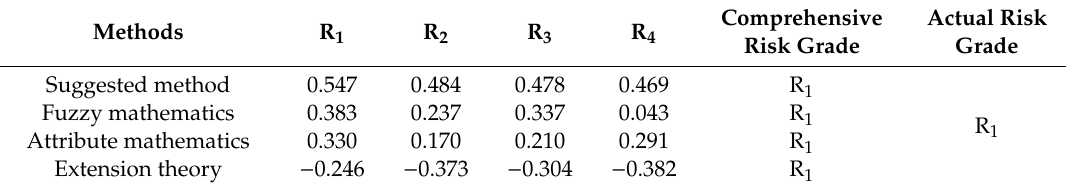
Table 9. Comparison among the results using di ff erent models [9,23].